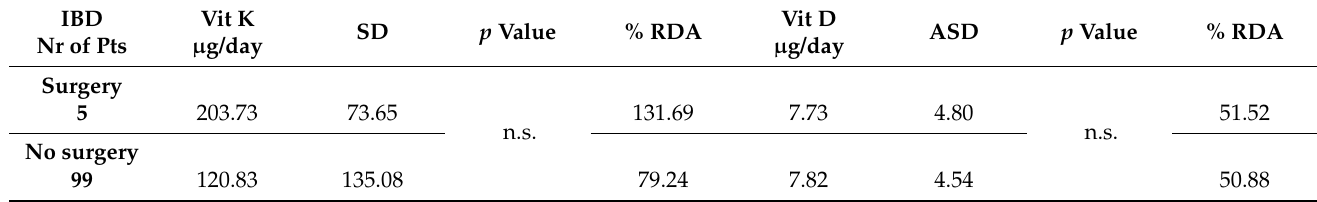
Table 7. Vitamin K and D intake and previous surgery in